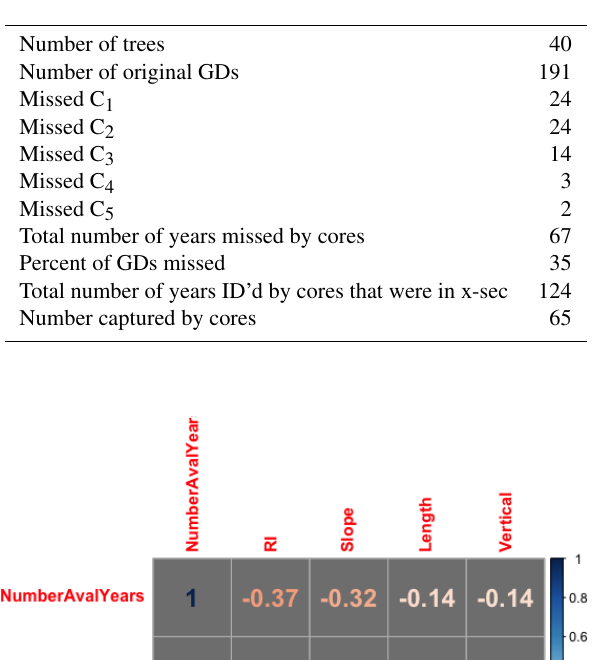
Table A4. Summary data of subset of samples ( n = 40) used to estimate number of GDs potentially missed if cores were analyzed instead of the entire cross section.